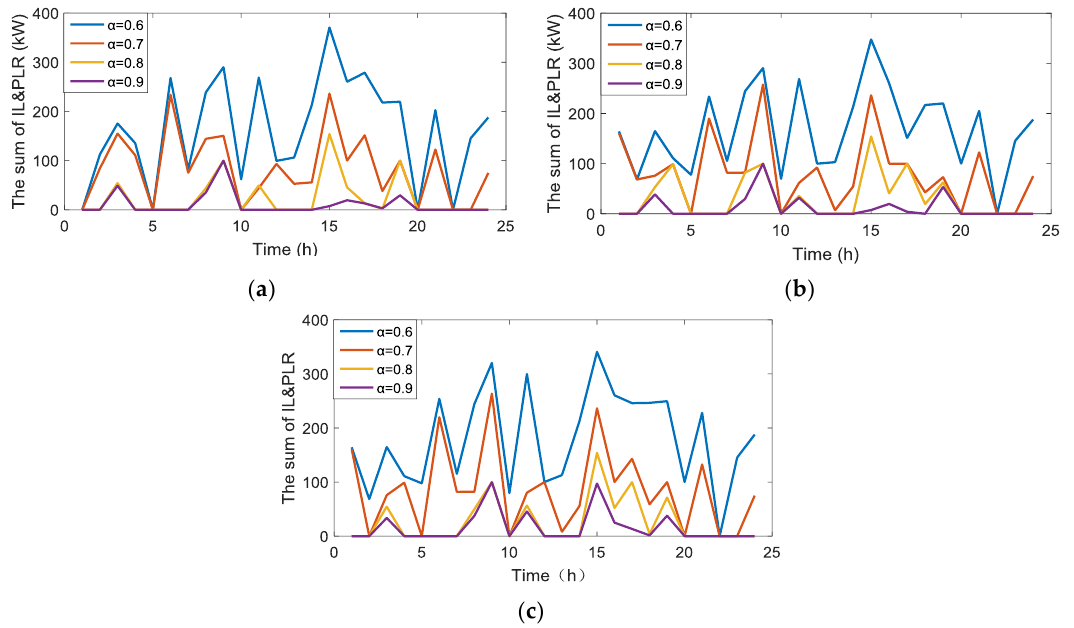
Figure 5. The output in each day-ahead credibility scenario: ( a ) Γ = 1; ( b ) Γ = 3; ( c ) Γ = 5.